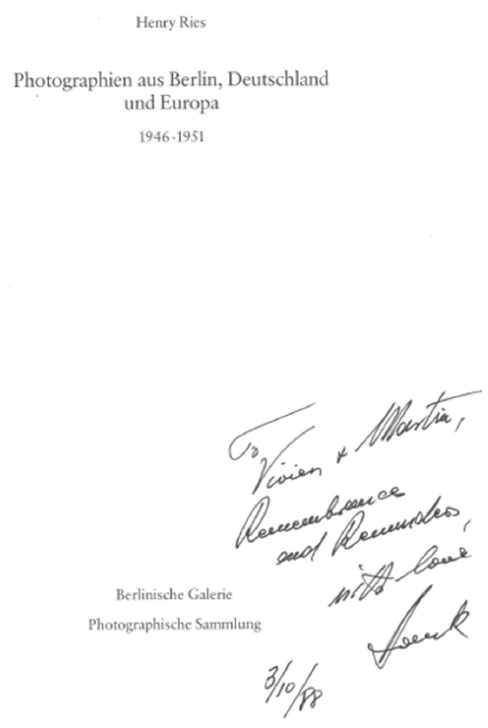
Figure 15. Henry Ries. Inscription to Vivien and Martin. Title page. 10 March 1988. Henry Ries: Photograpien aus Berlin, Deutshland und Europa, 1946–1951 , exh. cat. Berlin: Berlinische Galerie, 1988.